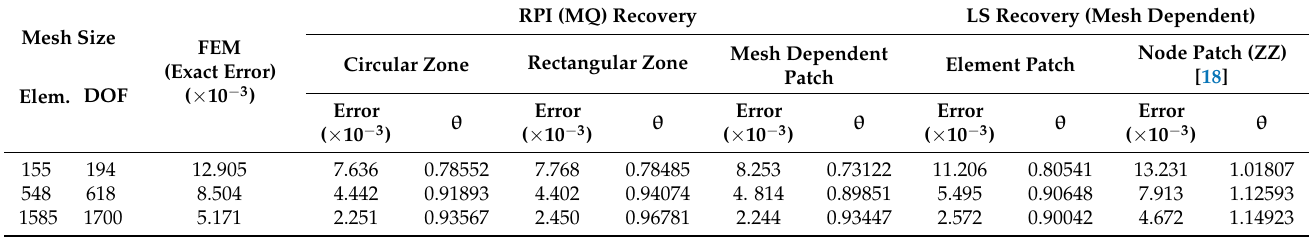
Table 11. Error convergence and global effectivity ( θ ) for plate problem with hole using RPI (MQ) with various mesh free node zones and least square based recovery techniques (linear triangular, energy norm).